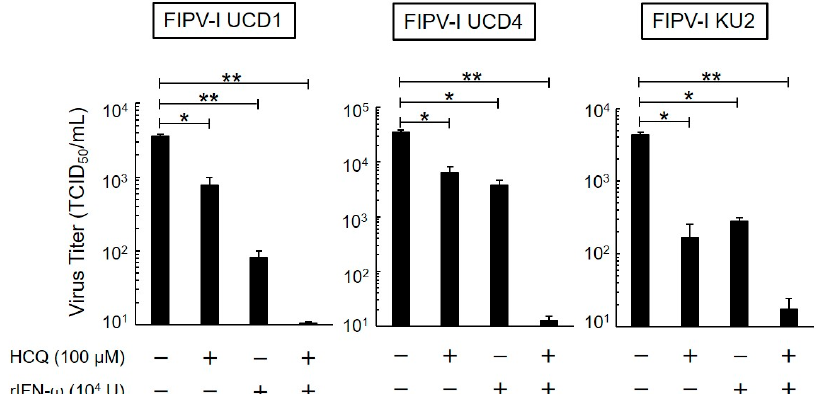
Figure 4. E ff ects of post-exposure on antiviral activity of HCQ and rfIFN- ω . Virus titer of type I FIPV-infected fcwf-4 cells post-treated with HCQ (100 µ M) and rfIFN- ω (10 4 U / mL). The results are shown as the mean ± SE. Data represent four independent experiments. ** p < 0.01 (* p < 0.05) vs. untreated (post-treated with medium only).